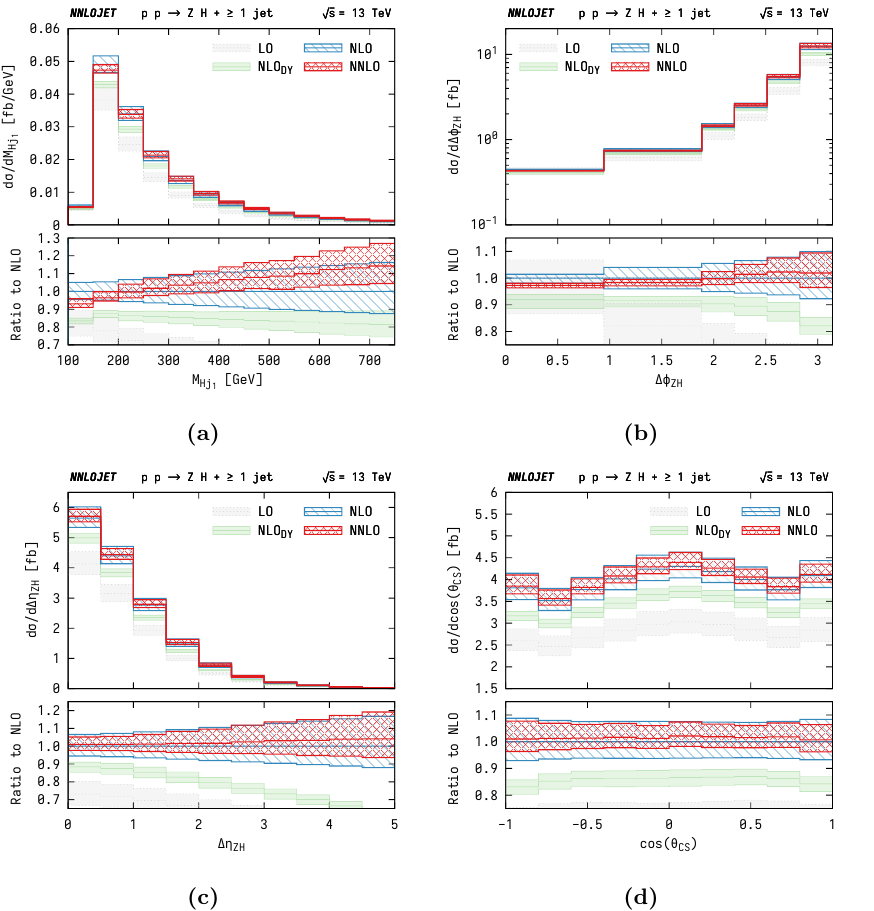
Figure 10. ZH+J observables for ZH signal: (a) M H j : the invariant mass distribution of the 1 Higgs boson-jet system, (b) ∆ φ ZH : the azimuthal angle separation Z and H boson, (c) ∆ η ZH : the pseudo-rapidity separation between the Z and H boson, (d) cos( θ CS ) : the Collins-Soper angle.